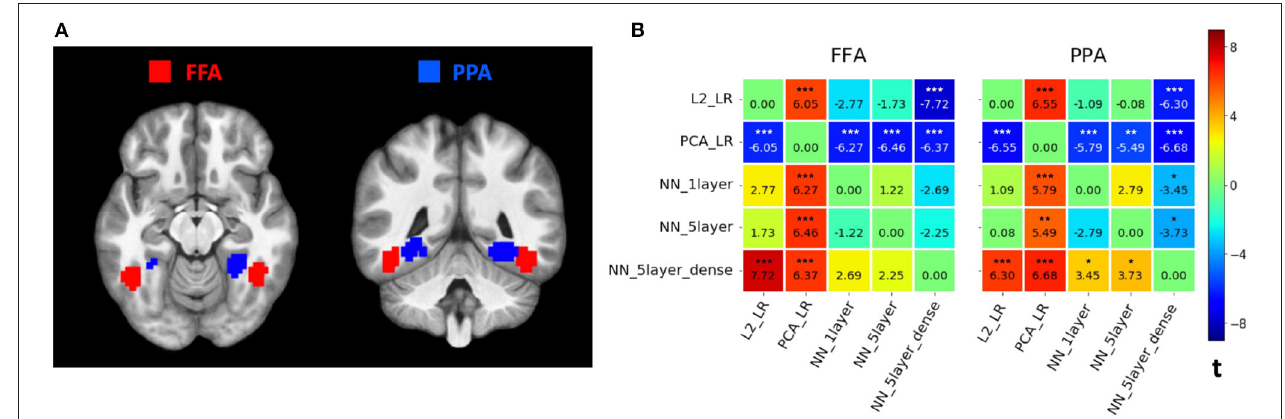
FIGURE 2 | (A) Seed regions. Example seed regions for one representative participant. The fusiform face areas (FFA) are shown in red, and the parahippocampal place areas (PPA) are shown in blue. Individual ROIs per participant were defined based on first-level t-maps, identifying 9 mm spheres centered on the peaks for the preferred category, and selecting the top 80 voxels with highest t -values within the spheres. (B) Comparison between different MVPD models. For each seed predictor region (left: FFA; right: PPA), we plotted the difference matrix of t -values across the five example MVPD models. As a measure of overall predictive accuracy, the average proportion of variance explained varExpl was computed across the whole brain for each model per participant. For each pair of models, we subtracted the varExpl of one model from another one, obtaining the pairwise difference values. Finally, we conducted a one-tailed t -test on the difference values across all 14 participants. The corresponding t -values were entered into the difference matrix, indicating the extent to which one model outperformed another one in terms of the overall predictive accuracy using the seed region as the predictor. Stars above t -values indicate the statistical significance (*** p < 0.001 ; ** p < 0.01 ; * p < 0.05;